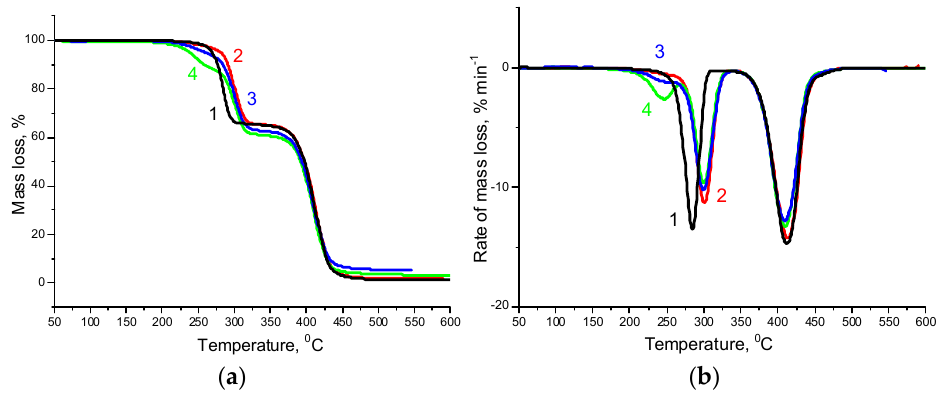
Figure 12. TG ( a ) and DTG ( b ) curves for the PHBV/PCL(1:2) mixture (1); PHBV/PCL(1:2)/